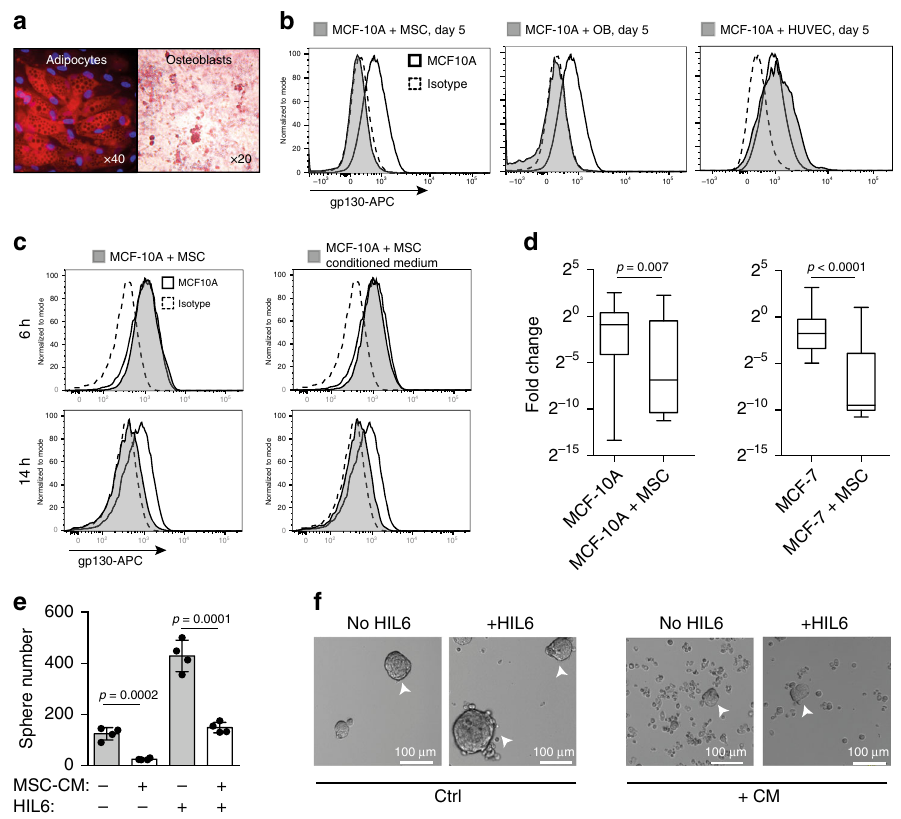
Fig. 6 gp130 downregulation by soluble factors of bone marrow stromal cells. a Mesenchymal stem cells were tested for their ability to differentiate in vitro into adipocytes (Nil oil red O staining) and osteoblasts (Alizarin red S staining). b Surface gp130 expression of MCF 10A after fi ve days of co-culture with primary mesenchymal stem cells (MSCs) from a breast cancer patient, primary osteoblasts (OBs) derived thereof or primary human umbilical vein endothelial cells (HUVECs). c Surface gp130 expression of MCF 10A after 6 and 14 h of co-culture with MSCs or MSC-conditioned medium. b , c Grey fi lled histograms indicate MCF 10A co-cultured with MSCs, OBs, HUVEC or MSC-conditioned medium. Histograms with a thick black line indicate MCF 10A cells cultured alone and dashed histograms isotype control staining for gp130. d gp130 gene expression levels determined by single cell qPCR of MCF 10A cultured for 5 days with ( n = 23) or without ( n = 37) MSCs and MCF- 7 cultured for 5 days with ( n = 20) or without ( n = 20) MSCs. Box and whisker plots show the MCF 10A (MCF-7) fold change cultured with MSCs relative to MCF 10A (MCF-7) cultured without MSCs with boxes marking the median, lower-quartile, and upper-quartile, and lines connecting the extremes. e , f MCF 10A cells were left untreated or pre-treated for 14 h with MSC-conditioned medium, washed and then tested for their ability to form spheres in the presence of endogenously produced IL6/sIL6RA or exogenously added HIL6. Sphere-formation was assessed after seven days, n = 4 for each group. P values according to two-sided Mann – Whitney test ( d ) or two-sided Student ’ s t-test ( e ). All error bars correspond to standard deviation (Mean ±